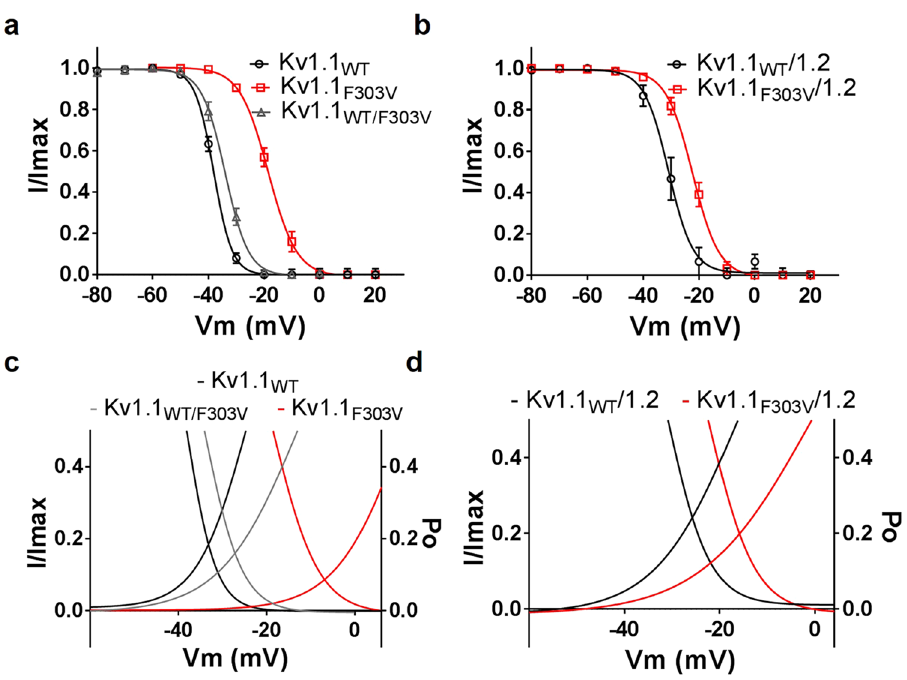
Figure 6. Effect of mutation on voltage-dependence of slow inactivation of Kv1.1 channels and on window currents. Cells were depolarized to various pre-pulse potentials, from − 80 mV to + 20 mV in + 10 mV increments for 20 seconds, and then held at + 40 mV test potential for 200 msec. Peak current amplitudes recorded at test potential of + 40 mV were normalized (I/Imax) and these values were plotted as a function of the pre-pulse potentials and fitted with a Boltzmann function. The mutation resulted in the positive shift of the inactivation-voltage relationships for both homomeric ( a ) and heteromeric ( b ) channels. F303V reduced both ( c ) Kv1.1 and ( d ) Kv1.1/1.2 window currents (the triangular areas under the overlapping point of the activation and inactivation curves of the respective